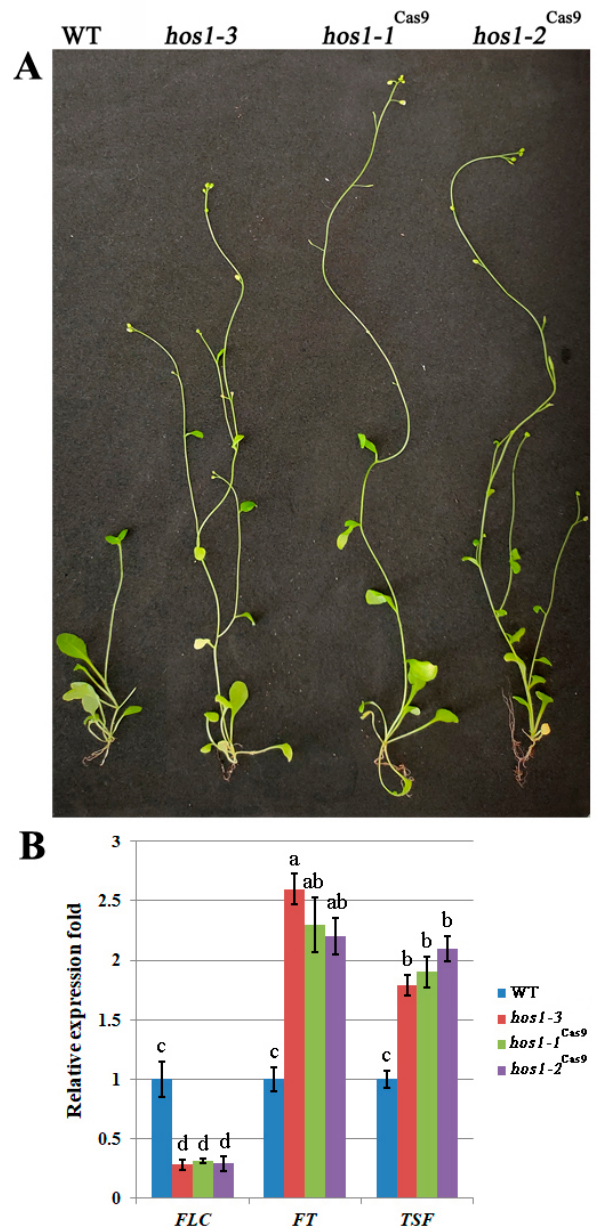
Figure 3. Phenotypic characterization of the hos1 Cas9 mutants and expression of flowering-time genes. ( A ) Flowering phenotype of hos1 mutant plants ( hos1-3 , hos1-1 Cas9 and hos1-2 Cas9 ) in comparison with wild-type (WT) genotype grown in LD conditions for 4 weeks; ( B ) qPCR analysis of FLC , FT and TSF expression. Data are presented as mean ± standard error. Different letters above the bars indicate statistically significant differences of means ( P < 0.05) for each of the genes (Fisher’s